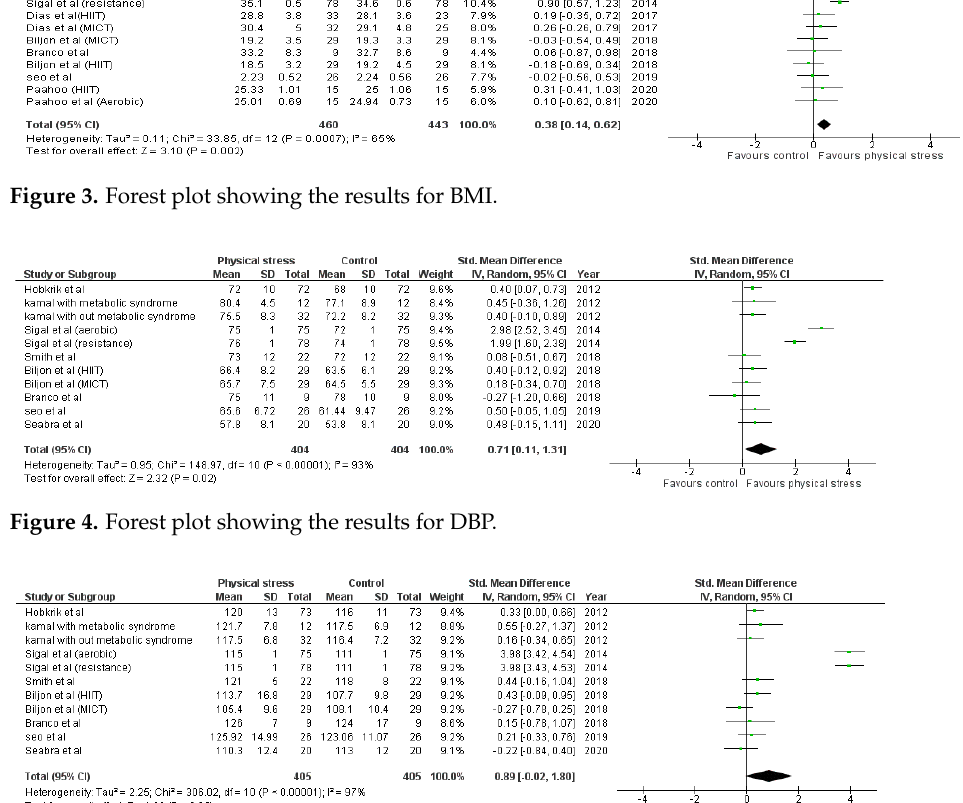
Figure 3. Forest plot showing the results for BMI.